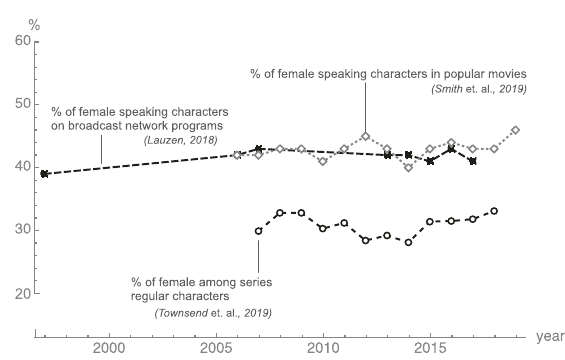
Fig. 2 Illustration of a selection of ratios found in the literature. The fi gure displays the temporal evolution (x-axis) of the ratio of women presence in various media (y-axis), based on Lauzen (2018), Smith et al. (2019), and Townsend et al. (2019).